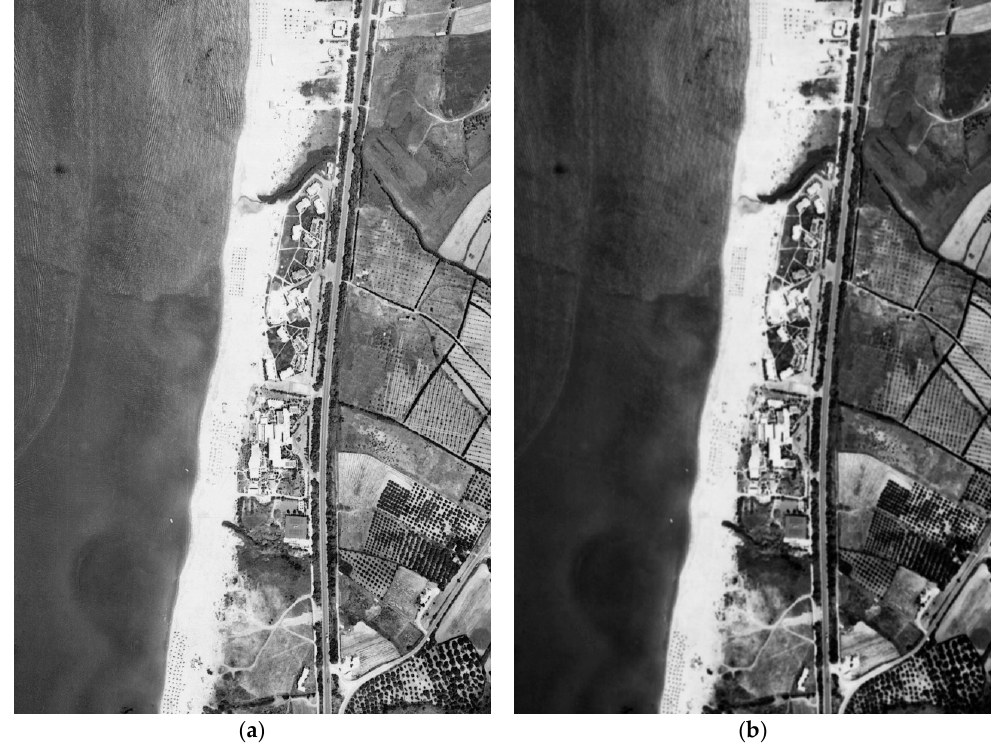
Figure 6. Automated coastline extraction from aerial imagery. ( a ) Initial image, ( b ) filtered and enhanced image.